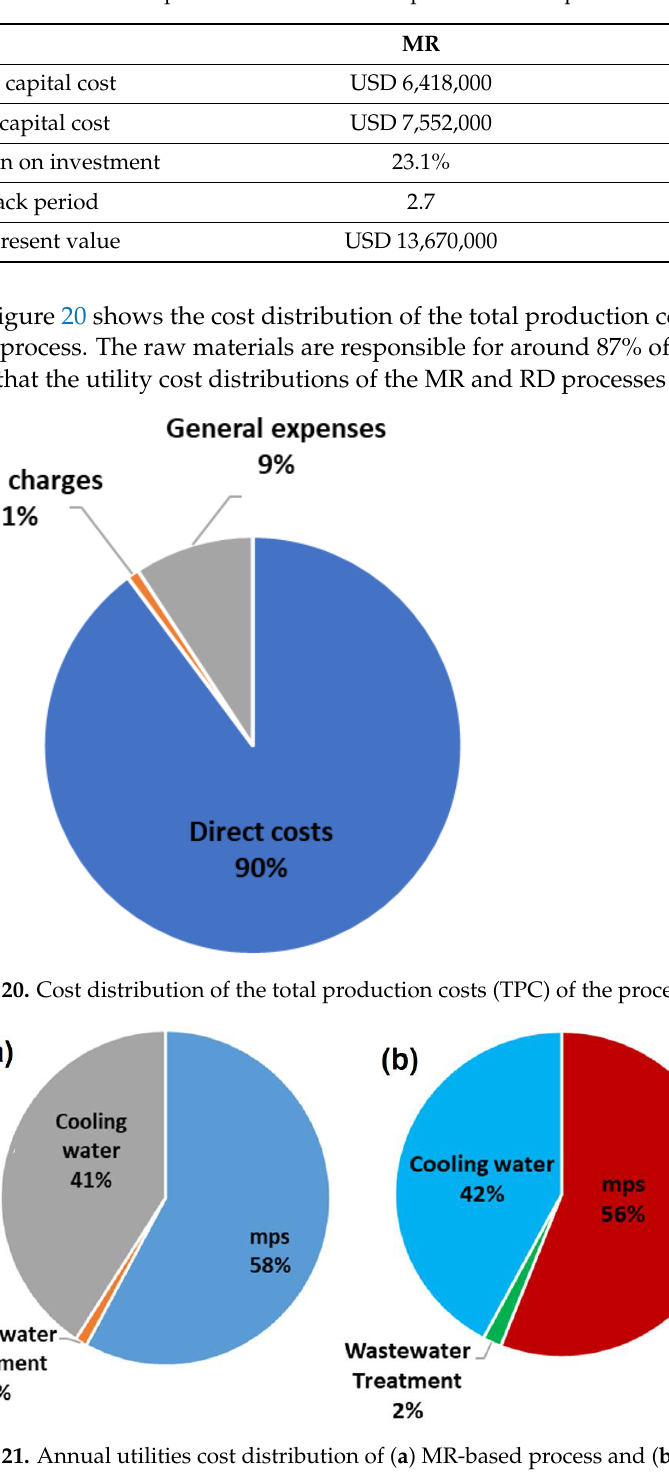
Table 12. Economic comparisons between the MR process and RD process for butyl acetate production.